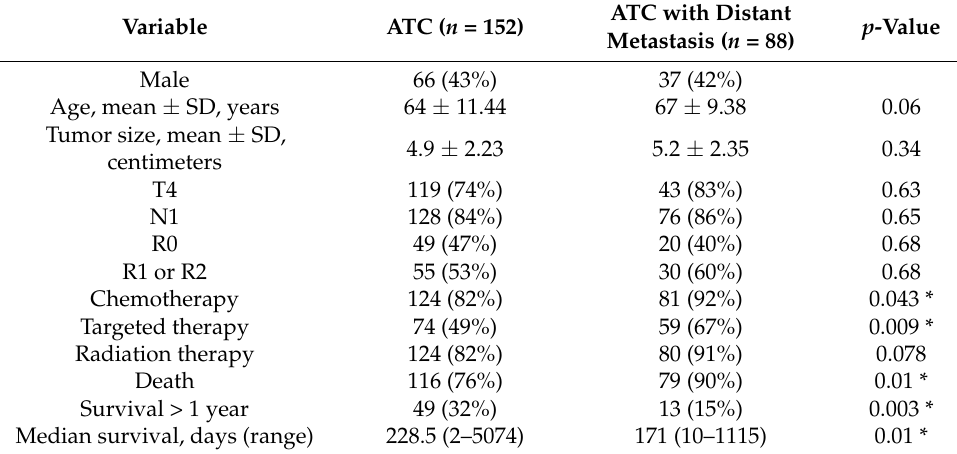
Table 2. Clinical features of patients with ATC and distant